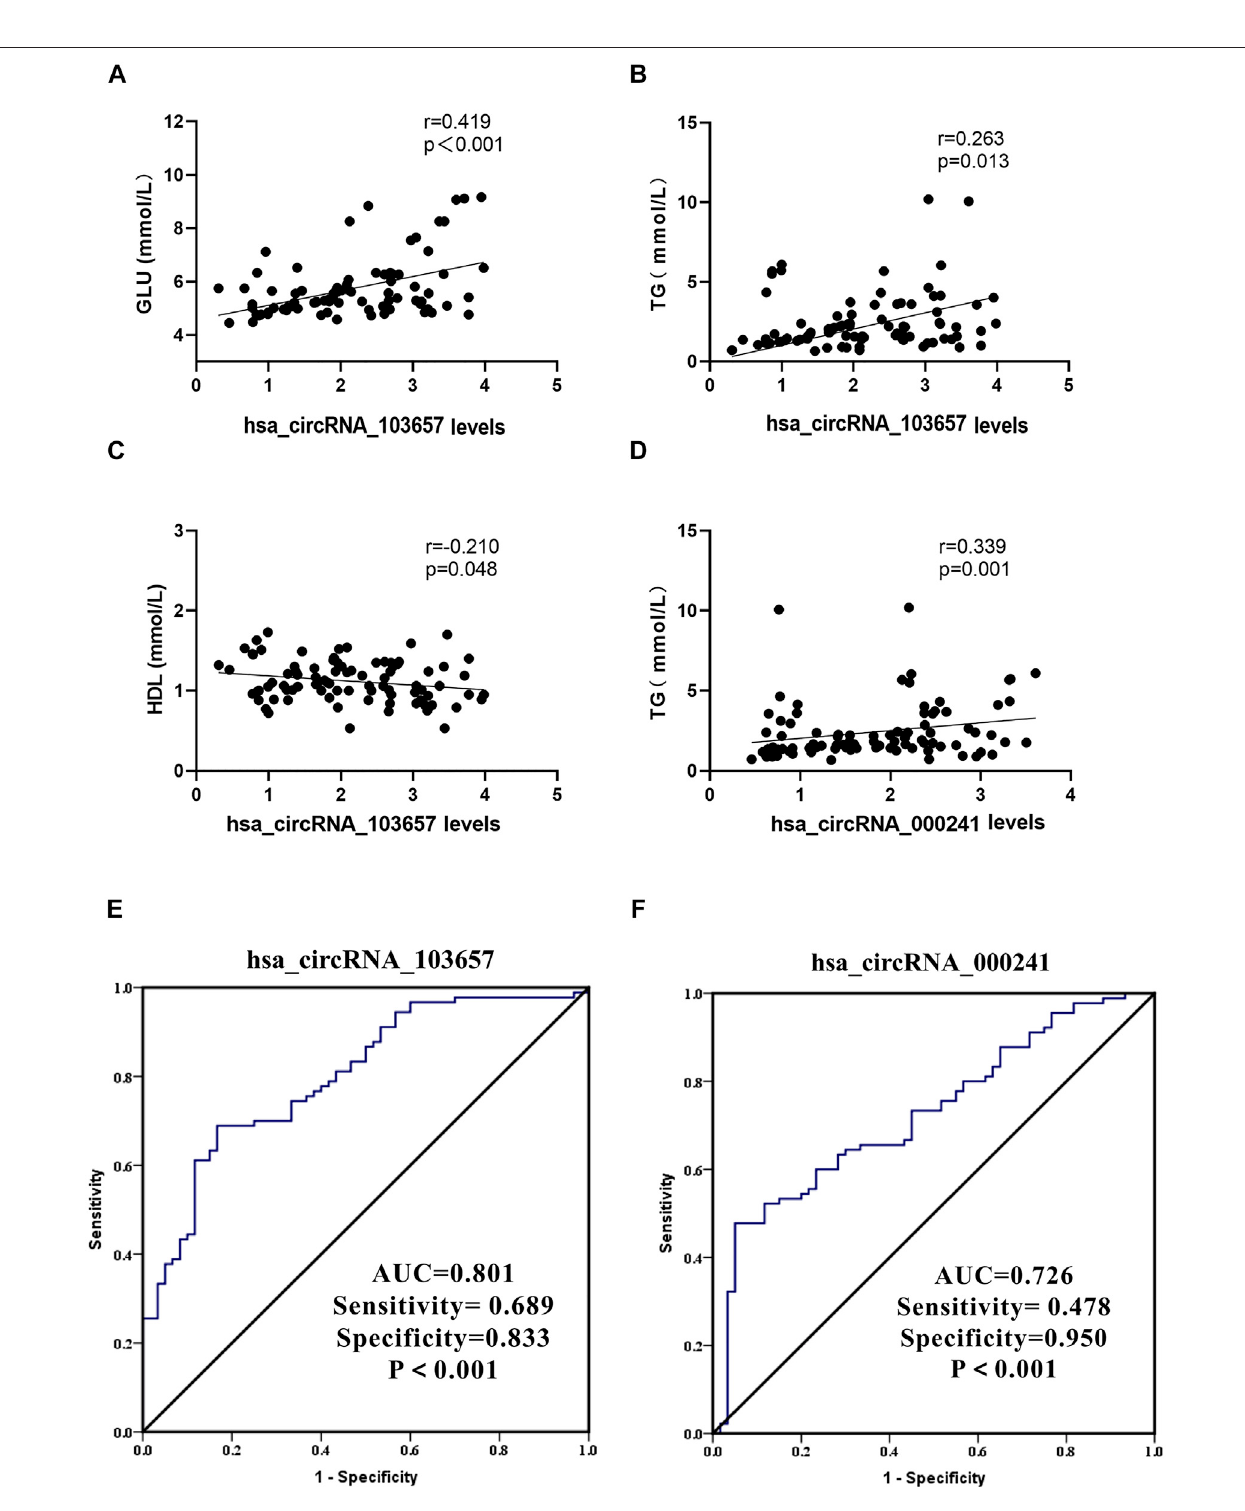
FIGURE 4 | Clinical signi fi cance of hsa_circRNA_103657 and hsa_circRNA_000241 in primary gout (A,B,C,D) Correlations between the expression levels of circRNAs (hsa_circRNA_103657 and hsa_circRNA_000241) and laboratory data of gout, analyzed using Spearman ’ s coef fi cient. (E, F) Receiver operating characteristic (ROC) curve for the analysis of the diagnostic value of hsa_circRNA_103657 and hsa_circRNA_000241 for primary gout. AUC: area under the curve.